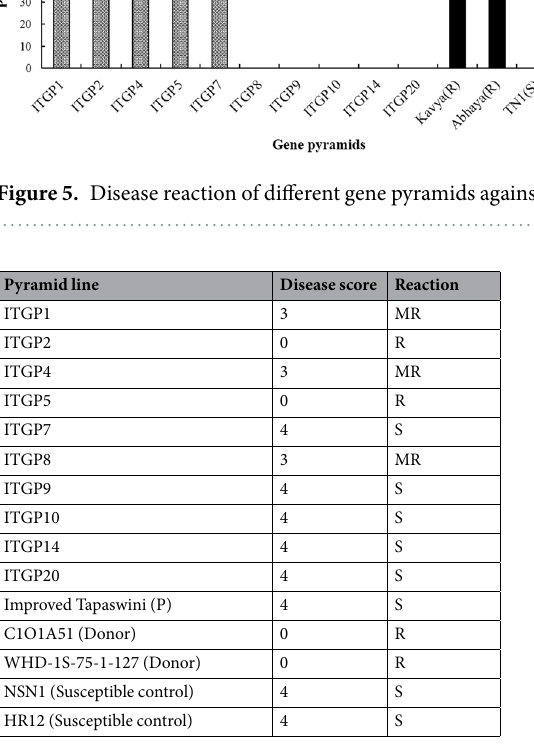
Table 2. Reaction of selected gene pyramids of Improved Tapaswini against blast. ITGP 1- ITGP 20 = Improved Tapaswini gene